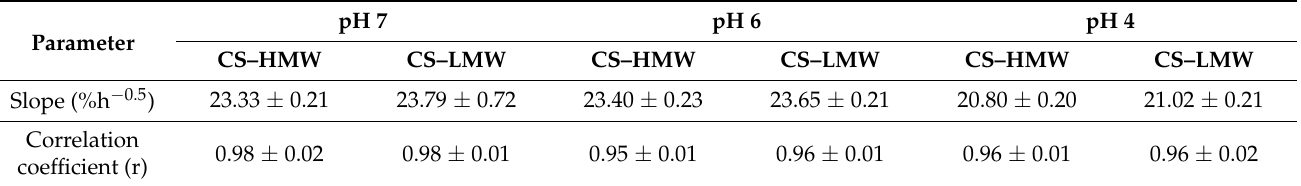
Table 5. Higuchi regression parameter of release percentage of drugs versus square root of time curves for release of AMG from CSNPs in PBS in 24 h.